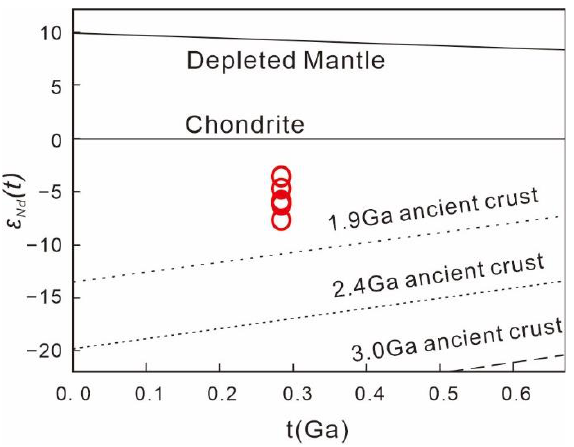
Figure 6. ε Nd (t)-t diagrams of the Zhaojinggou monzogranite. The initial Sr-Nd isotopic compositions of granites were rectified by the correspond- ing zircon U-Pb age of 286.7 Ma. The 87 Sr/ 86 Sr values of granites ranged from 0.715233 to 0.716612, and the average value was 0.7160, which was obviously higher than the original mantle value ( 87 Sr/ 86 Sr = 0.7045, [23]). The 143 Nd/ 144 Nd values of granites ranged from 0.511989 to 0.512021, and the average value was 0.512000, which was slightly lower than